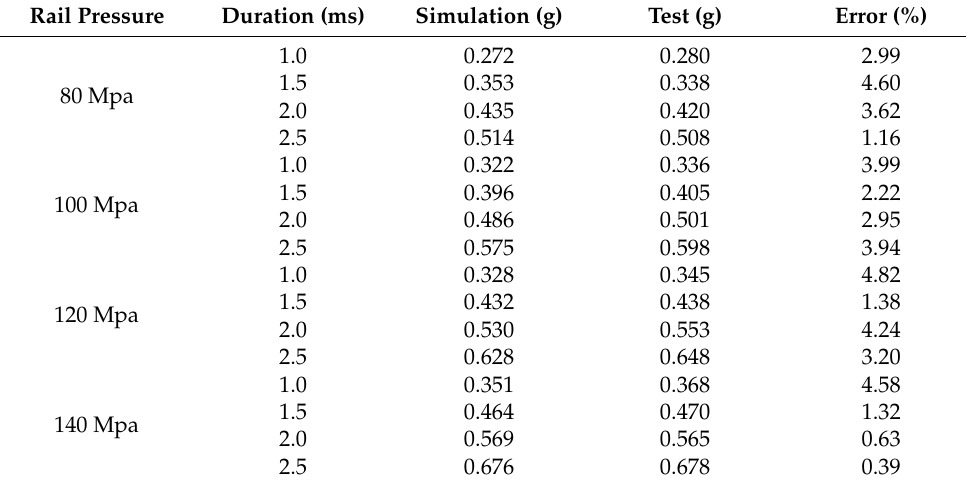
Figure 5. Performance simulation validation of a high-pressure common rail fuel system. Fuel injection per cycle under different rail pressures. Table 1. Error comparison under different rail